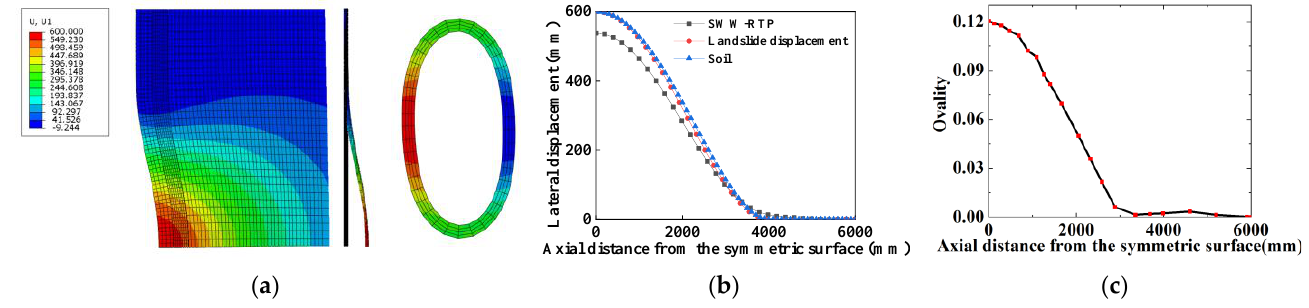
Figure 9. The deformation of the SWW-RTP in soil. ( a ) contour plot of deflection of the SWW-RTP; ( b ) SWW-RTP deflection distribution; ( c ) flattening deformation of cross-section along the pipe’s axial direction.